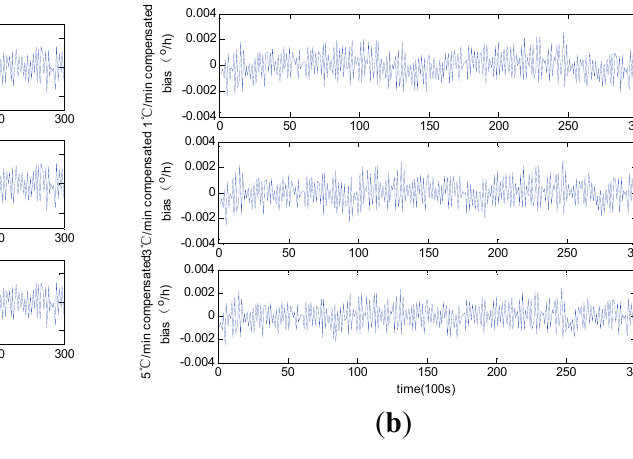
Figure 9. Compensated zero bias history using MLR: ( a ) constant temperature; ( b ) variable